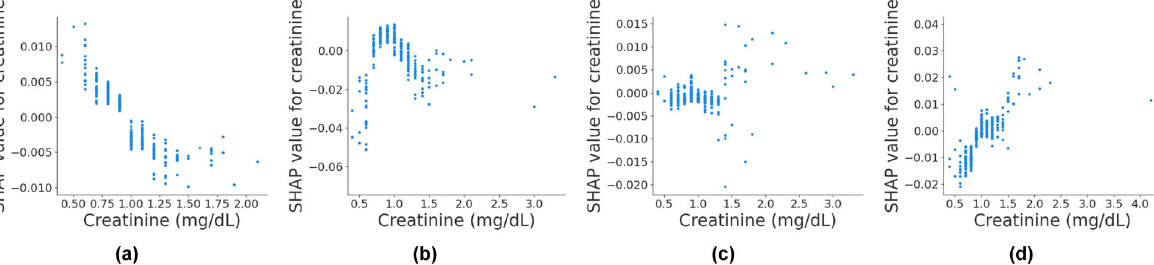
Fig. 1 An example of a variable with non-robust contribution behavior. a , b , c , and d are the SHAP contribution of creatinine levels to the predicted risk score when training on different bootstrapping sample sets.